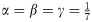
Performance functions in log-linear model space for the tasks of noise and precision.(A) First-order-precision performance function contours show a line of formulae which are accurate to the first order, including Bliss, pairs, regression and other formulae. (B) Second order precision performance function contours show that only formula accurate to the second order is the regression formula. (C) Noise performance function contours in case there is no noise in the wild type measurement, the noise is zero at β= 0,γ = 0. (D) Noise performance function contours in case there is noise in the wild type measurement, the noise is minimal at α=β=γ=17.